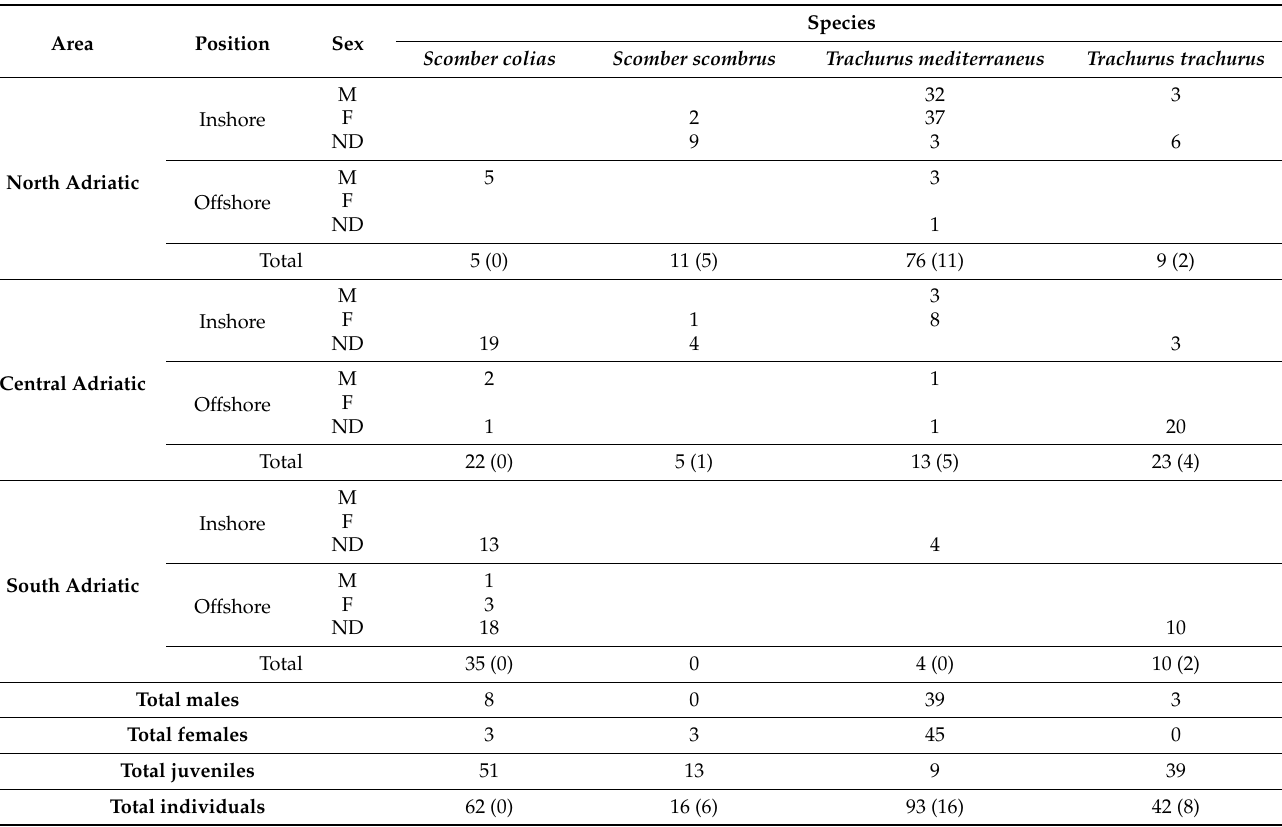
Table 2. Total number of male (M), female (F) and juvenile (ND) specimens of each of the four pelagic species collected at each depth (inshore and offshore position) in each sampling area (North, Central and South Adriatic). Numbers in brackets (x) in the last line indicate the number of empty stomachs found for that species (stomach fullness <